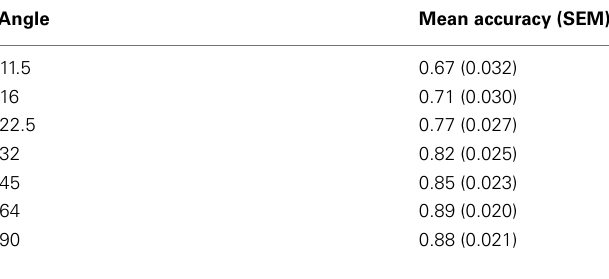
Table 1 |Average accuracy scores per angular distance (and average within-subjects standard error of the mean, Loftus and Masson,